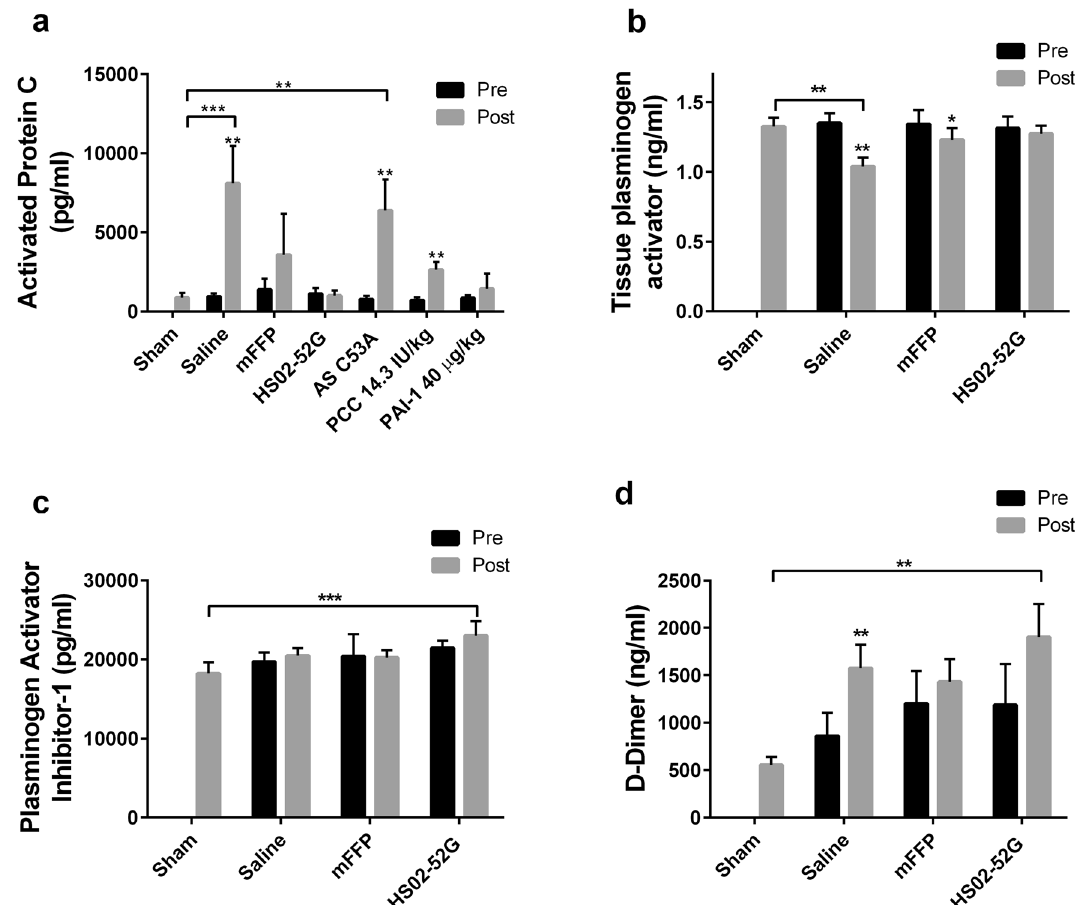
Figure 5. Coagulation and fibrinolytic markers in plasma from HS model mice. Plasma samples taken Pre-HS and Post-HS/resuscitation/liver laceration were assayed for the activities of activated protein C ( A ), tissue plasminogen activator ( B ), and plasminogen activator inhibitor-1 ( C ), as well as the concentration of D-dimer ( D ). Pre and Post, as in Figs. 3 and 4. The means of 6 determinations ± SD are shown in ( A ) and 5 determinations ± SD in ( B ), ( C ), and ( D ). Asterisks atop “Post” bars indicate statistical differences from corresponding Pre values by Wilcoxon test; asterisks above horizontal brackets refer to statistical differences between groups Kruskal–Wallis test with Dunn’s post-tests. In both instances: * p < 0.05, ** p < 0.01, *** p <